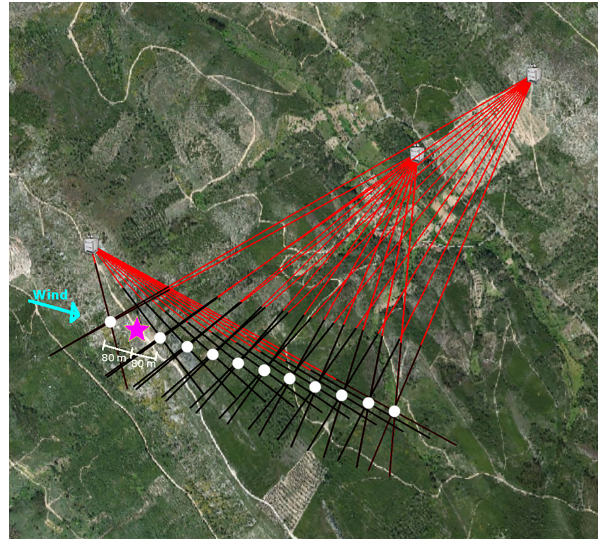
Figure 2. Visualization of multi-Doppler wake measurement sce- nario. Red represents the lidar beams, black represents the area with 2m separated range gates, the pink star is the wind turbine and the white dots are the center range gates where lidar beams